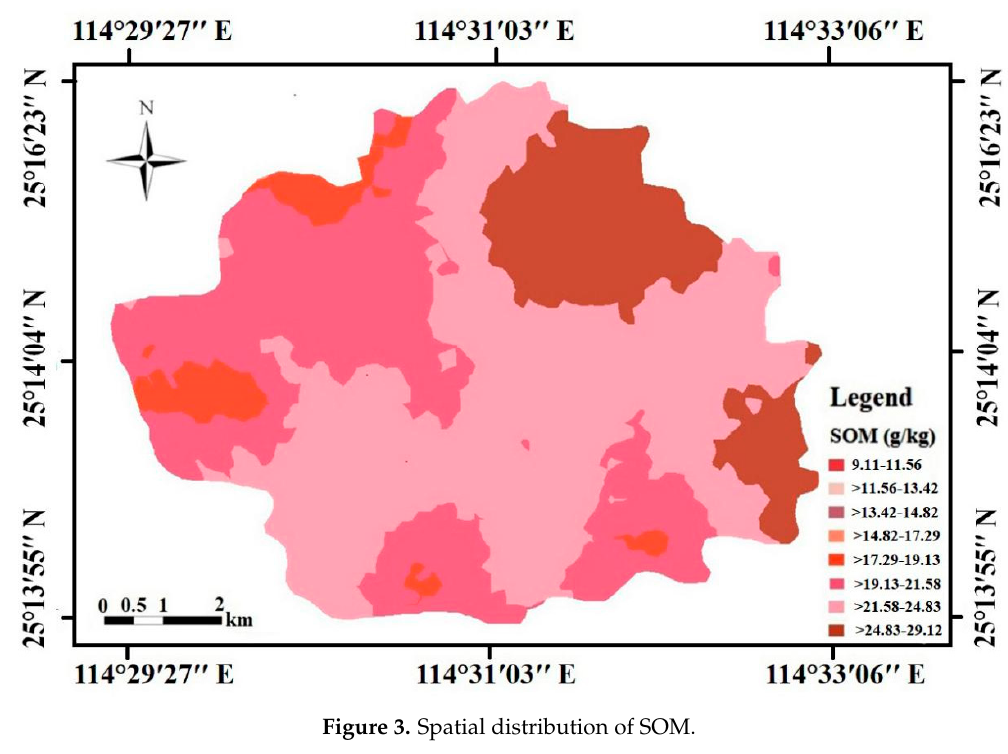
Figure 3. Spatial distribution of SOM.